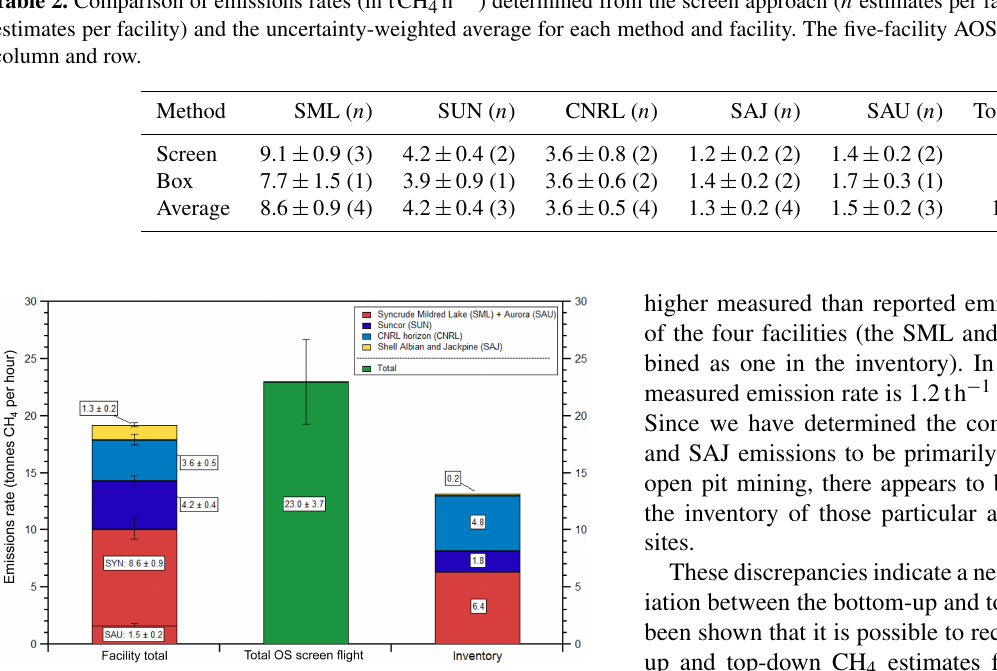
Figure 8. Comparison of emissions rates determined for the five major facilities (SML, SAU, SUN, CNRL, SAJ, SAU) with the to- tal OS screen flight (see Fig. 7 for the flight track). Also shown is the CH 4 emissions taken from the Canadian GHGRP Emissions Inventory for the year 2013, scaled down from annual to hourly emissions assuming constant temporal emissions. Note that in the inventory, SML and SAU emissions are reported as a single facility, while our estimates are derived